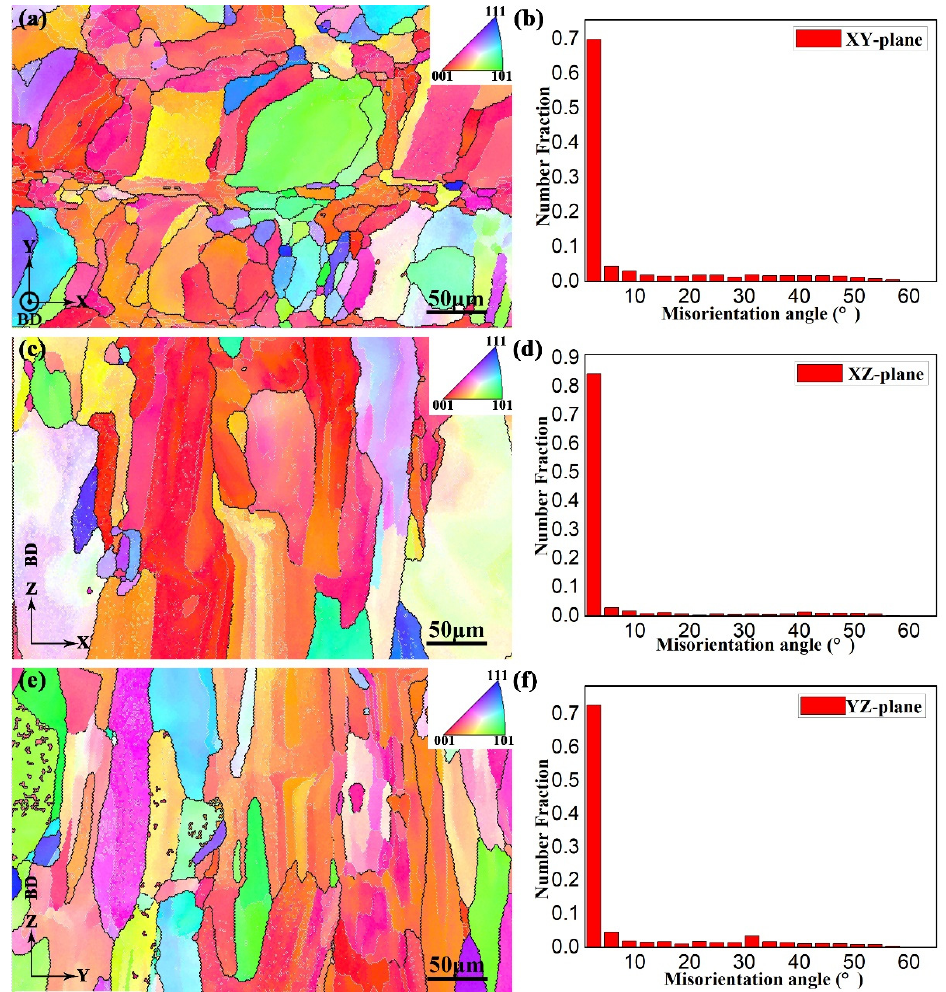
Figure 8. The EBSD inverse pole figure (IPF) maps of sample X at ( a ) XY-, ( c ) XZ-, and ( e ) YZ-planes, respectively. Misorientation angle distribution at ( b ) XY-, ( d ) XZ-, and ( f ) YZ-planes, respectively.